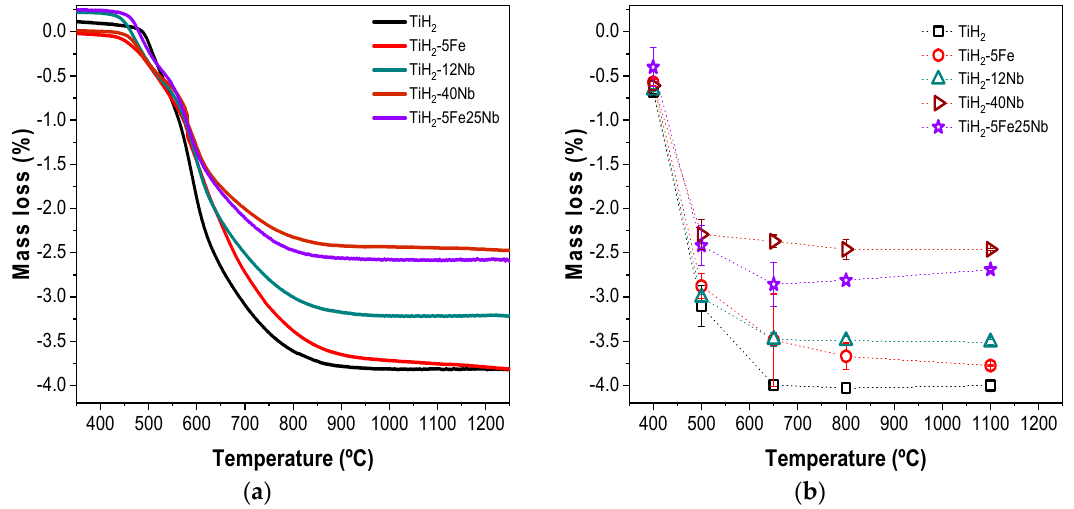
Figure 4. Mass loss for the composition prepared obtained by: ( a ) Thermogravimetric analysis (TGA) of mixtures of powders (samples measured under argon flow of 80 mL/min) and ( b ) Vacuum treatments (VAC) of compact samples (samples treated under high-vacuum conditions).